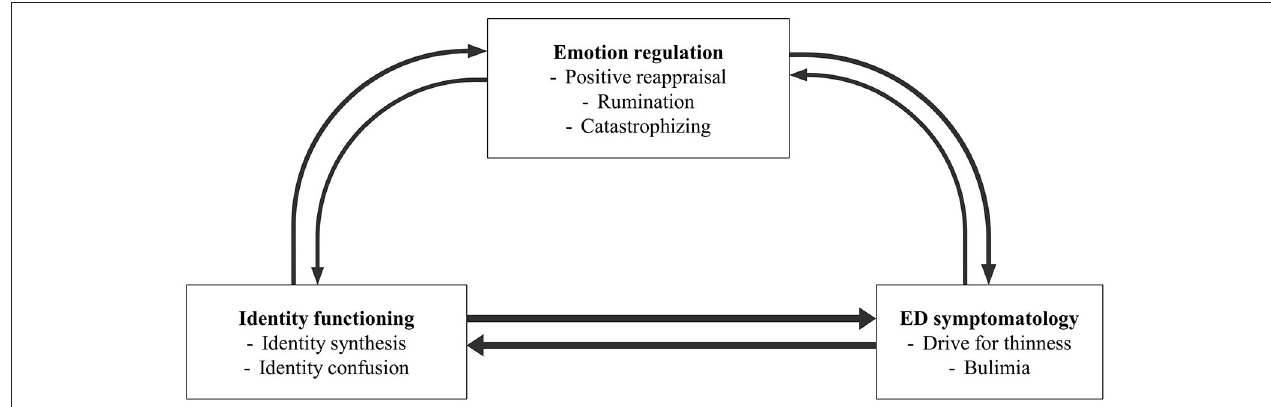
FIGURE 1 | Theoretical model based on the